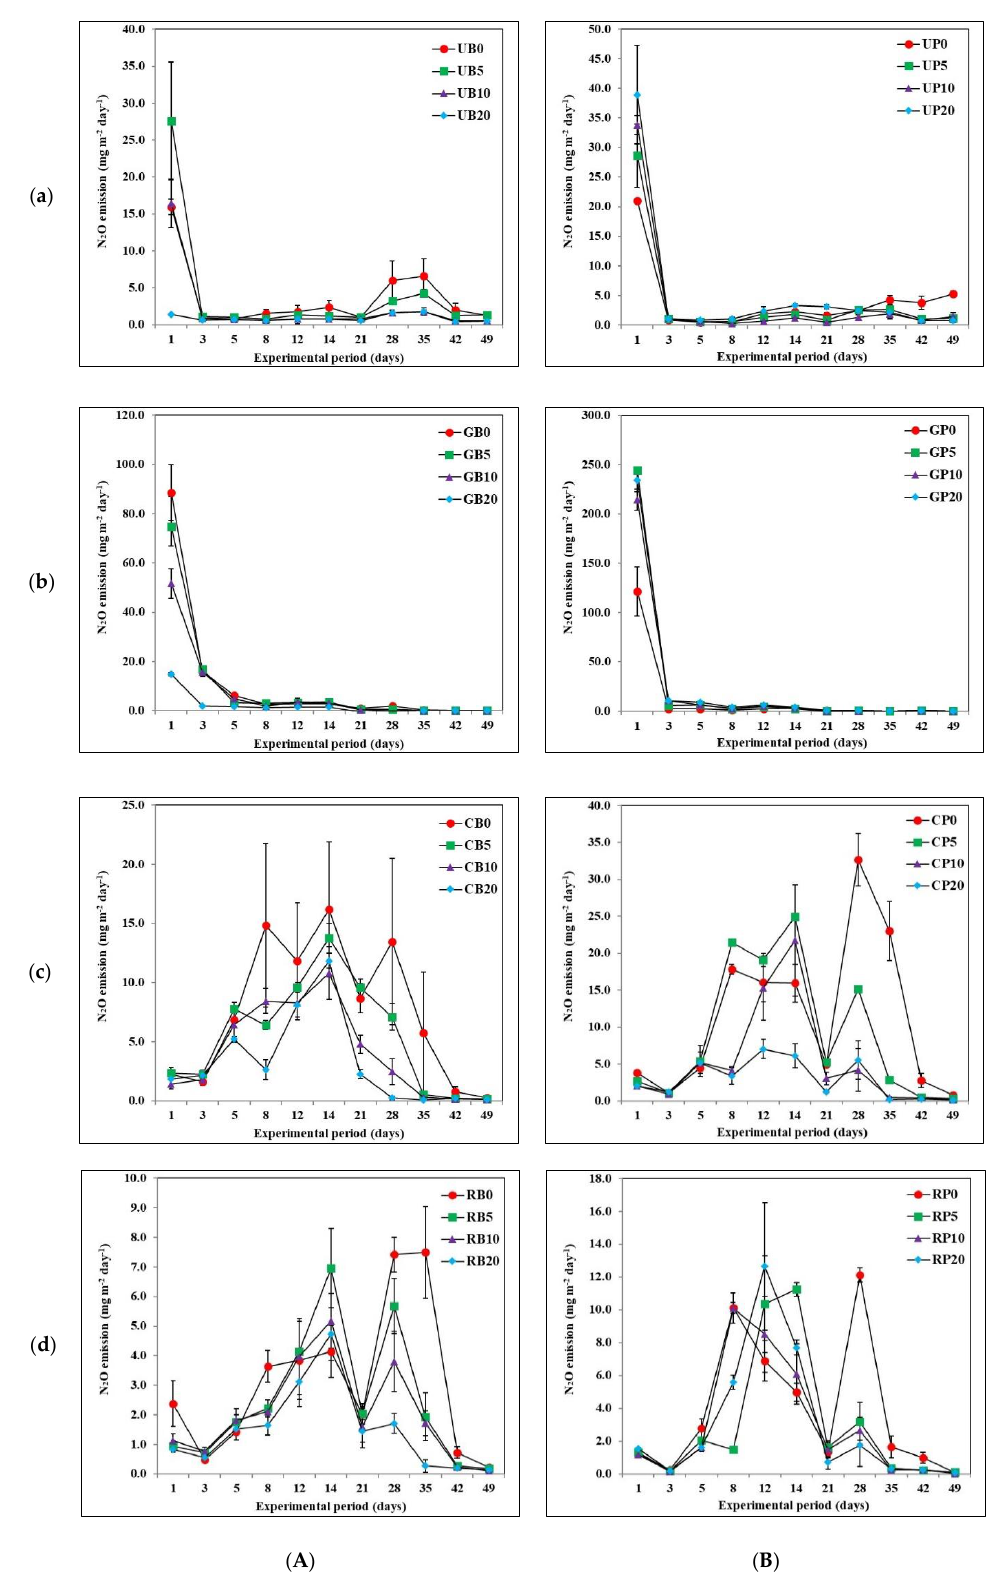
Figure 1. N 2 O emission according to soil characteristics under incubation conditions during the 49 days. The error bars represent standard errors (n = 3). ( a ): upland, ( b ): greenhouse, ( c ): converted land, ( d ): reclaimed land. ( A ): barley straw biochar, ( B ): poultry manure biochar.